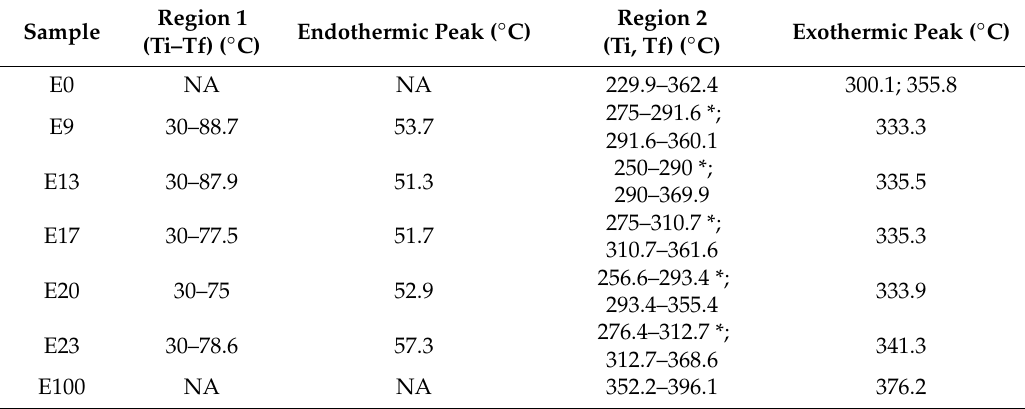
Table 4. Initial, final and peak point of events obtained from DTA